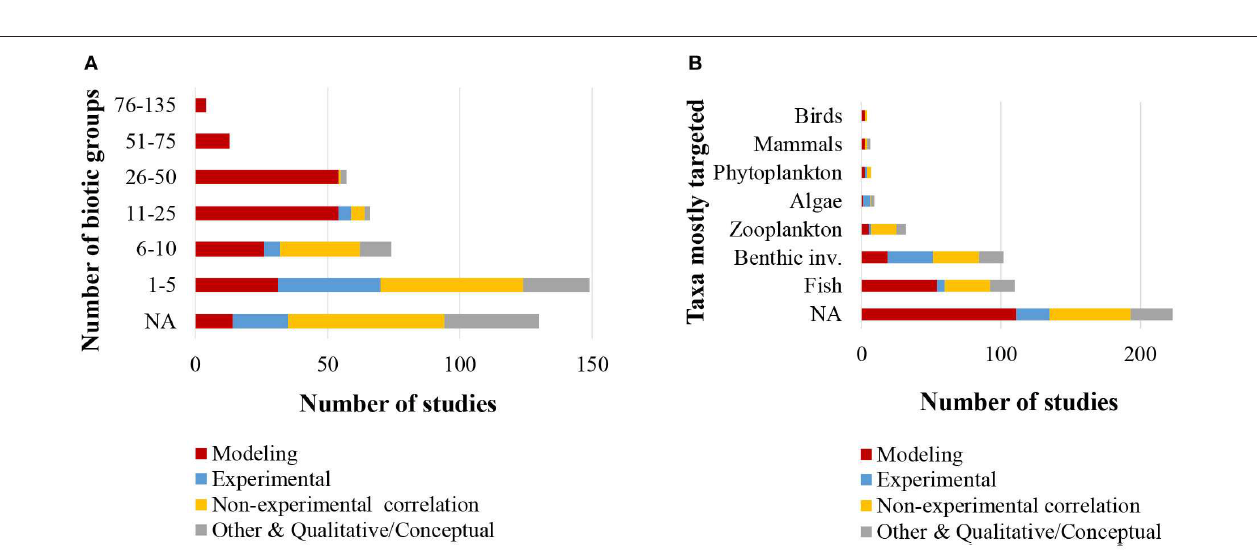
FIGURE 4 | (A) Number of biotic groups considered ( N = 493); (B) Taxonomic groups that studies focused in ( N = 493). NA, Not applicable.